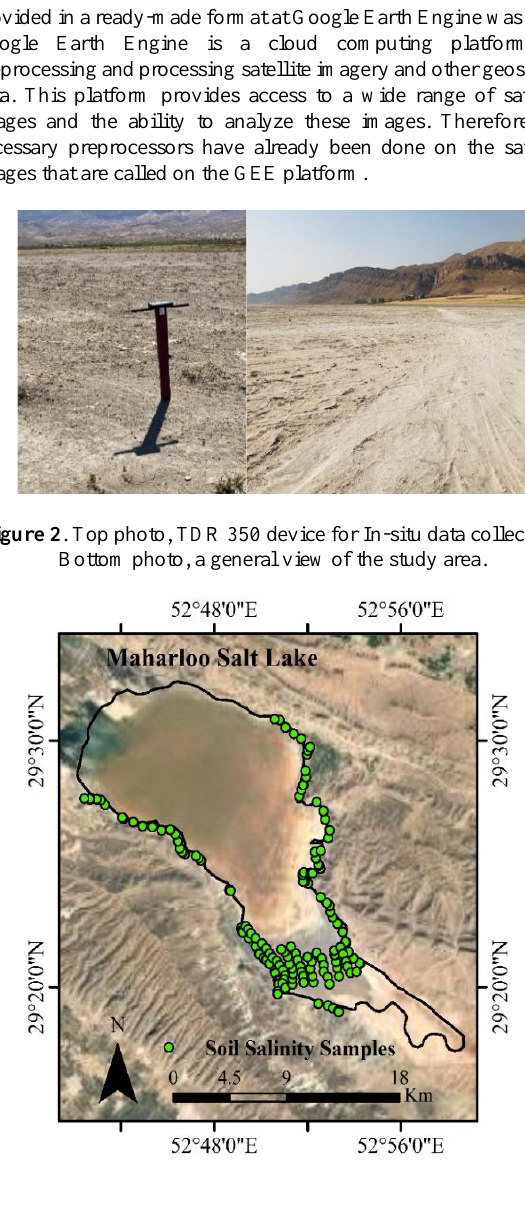
Figure 3 . The study area of Maharloo Salt Lake with the ground data locations.